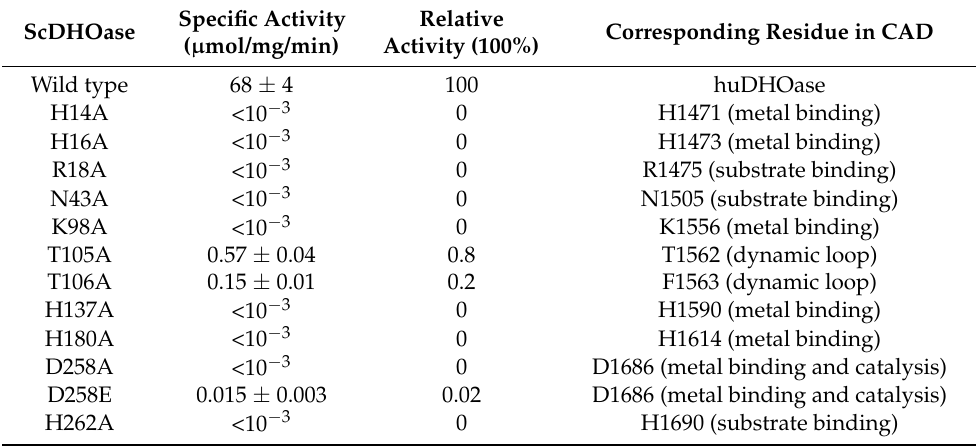
Figure 6. PLU is a competitive inhibitor of ScDHOase. PLU (50 µ M) was included in the standard assay for analyzing the enzyme activity under different substrate concentrations. Inhibition of ScDHOase by PLU resulted in a Lineweaver–Burk plot where the lines cross the y-axis at a similar point, indicating that PLU is a competitive inhibitor for ScDHOase. Data points are an average of three determinations within the 10% error. Table 2. Mutational analysis of